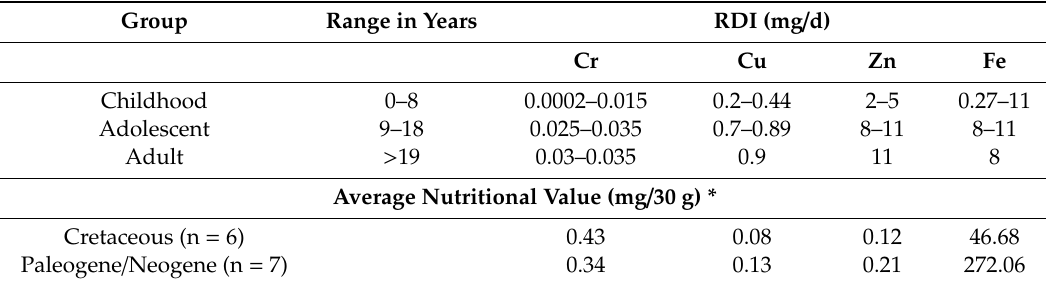
Table 4. Recommended dietary intake (RDI; [54]) and the average nutritional value of Cr, Cu, Zn, and Fe in the Cretaceous and Paleogene / Neogene geophagic kaolinitic clays, Nigeria.